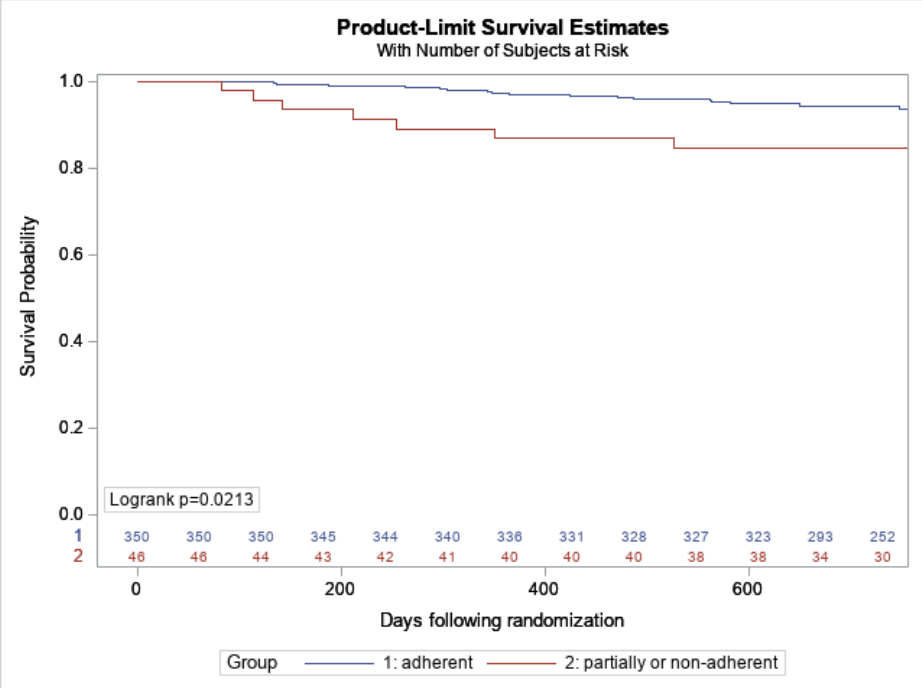
Figure 1. Kaplan–Meier probability of cardiovascular mortality-free survival in adherent patients vs. partially and non-adherent patients.